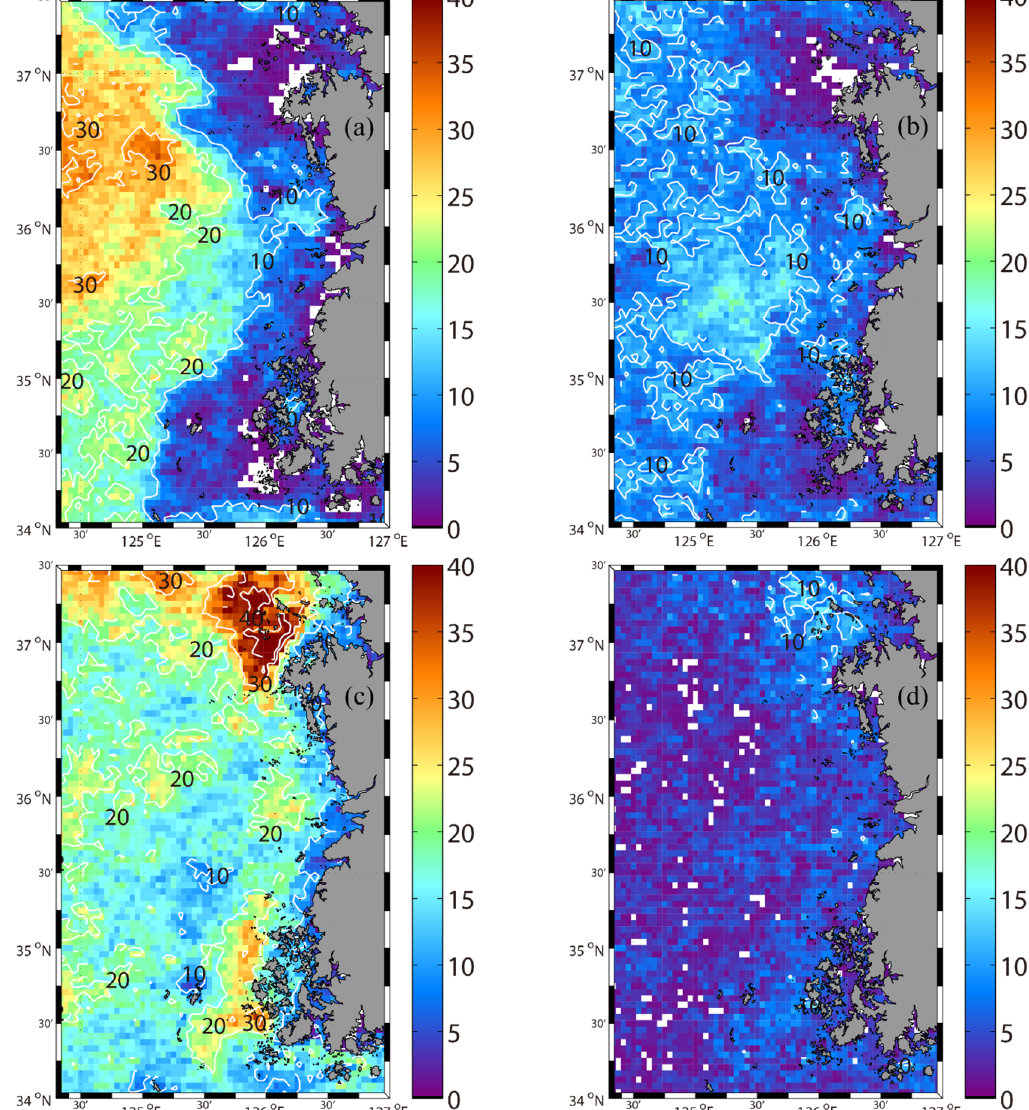
Figure 12. The number of AVHRR PFV53 L3 satellite SST observation data with ( a ) best, ( b ) acceptable, ( c ) low, and ( d ) bad quality flags in June and July from 2010 to 2013.